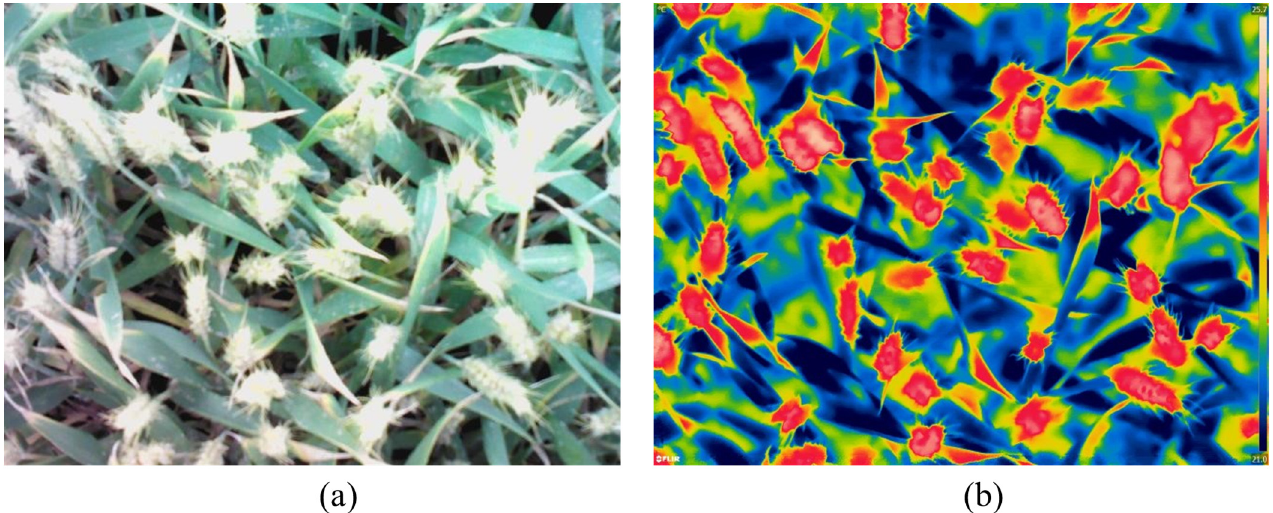
Figure 1. Wheat canopy RGB image ( a ) and thermal infrared image ( b ) obtained using thermal infrared camera.